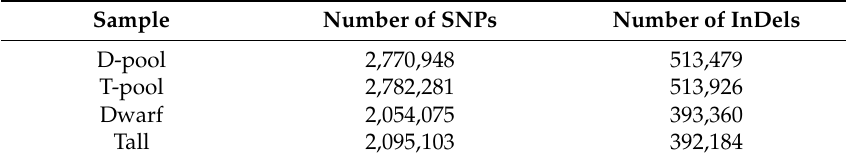
Table 4. Numbers of single-nucleotide polymorphisms (SNPs) and insertions/deletions (InDels) for each sample.